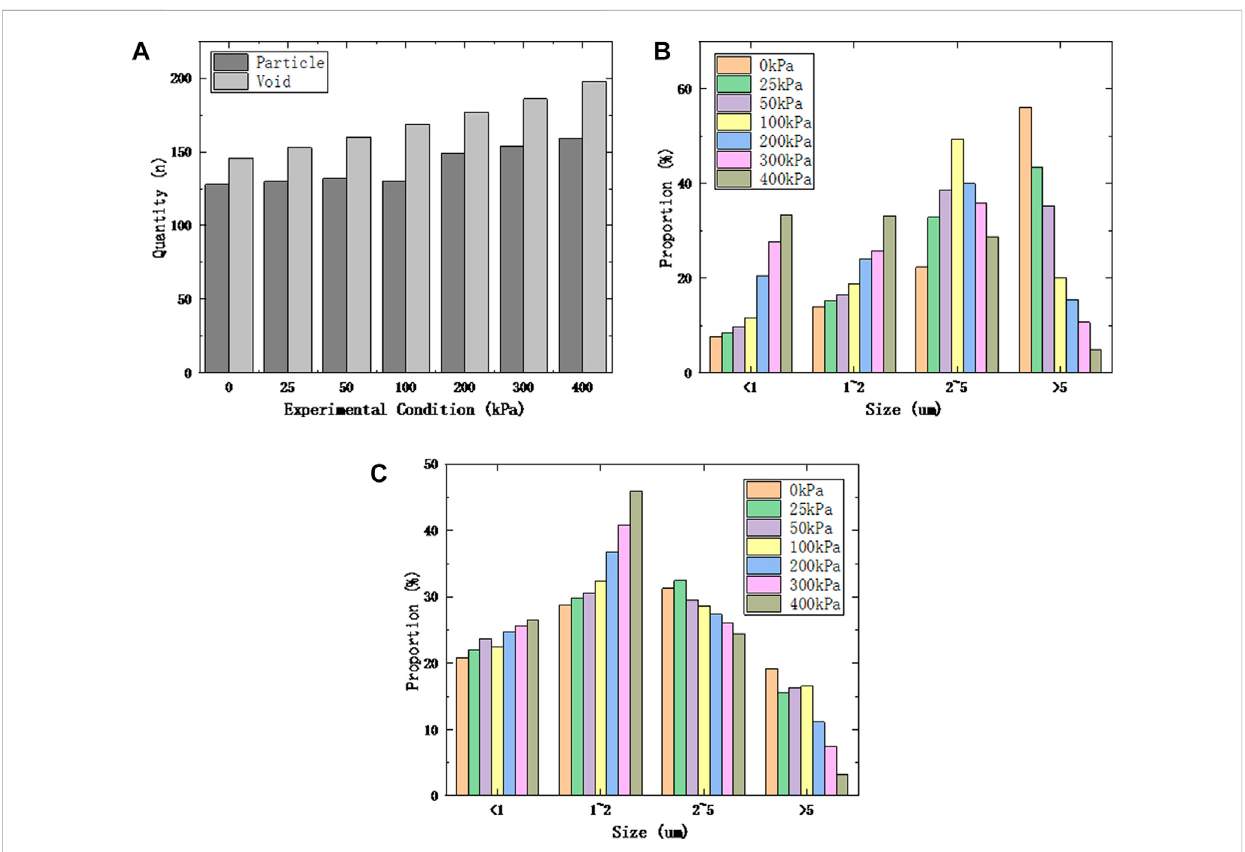
FIGURE 6 (A) The quantity of particles and pores. (B) The diameter distribution of particles. (C) The diameter distribution of pores.